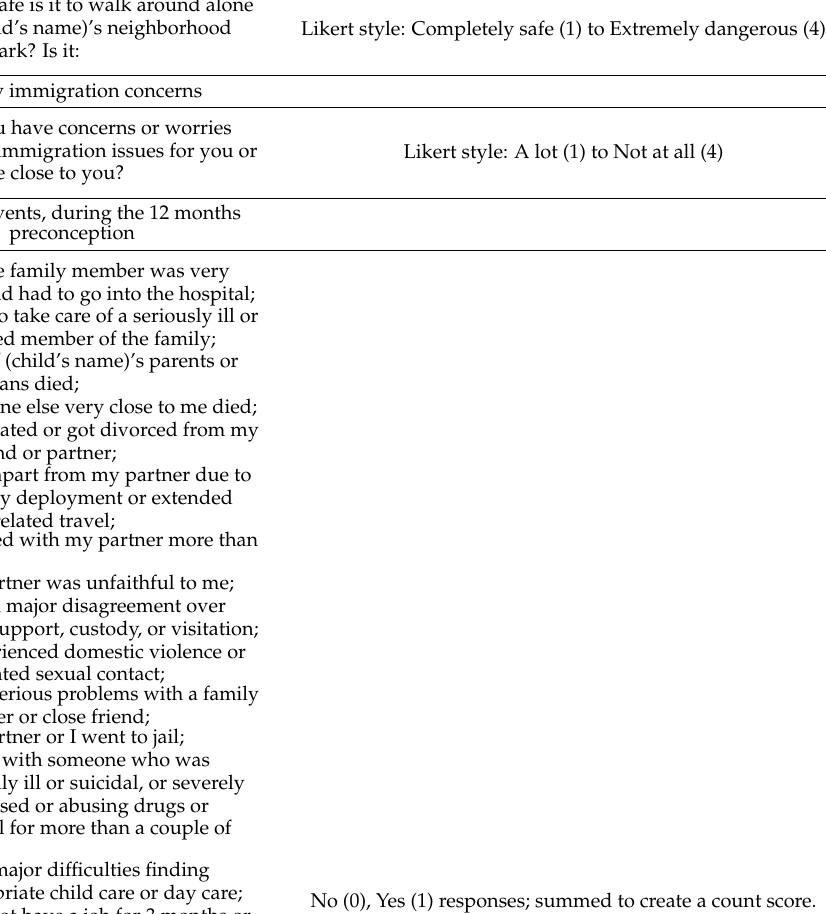
Table 1. Cont. Neighborhood